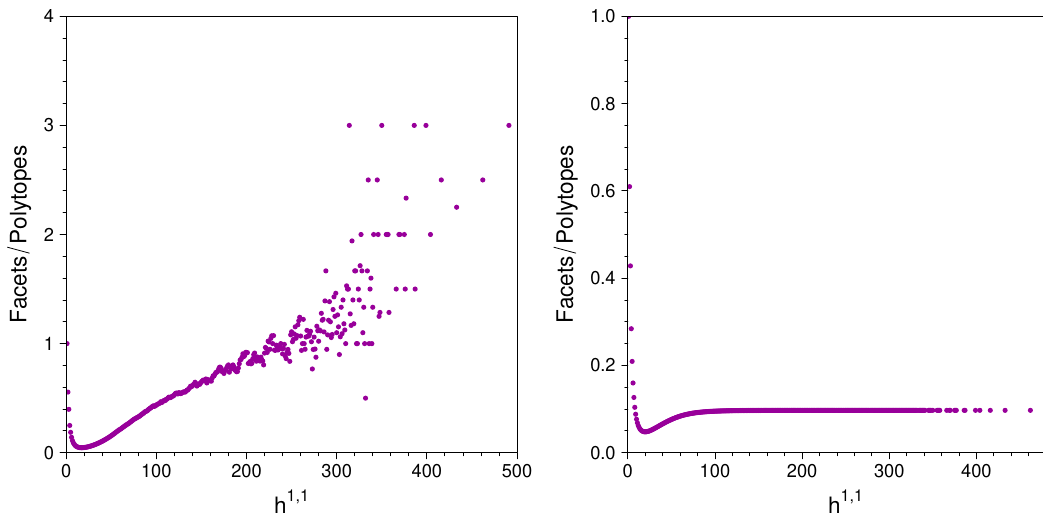
Figure 2 . (Left) The number of new facets at each h 1 ; 1 value, as a fraction of the number of polytopes at that h 1 ; 1 . (Right) The total number of facets found through each h 1 ; 1 value, as a fraction of the total number of polytopes up to that